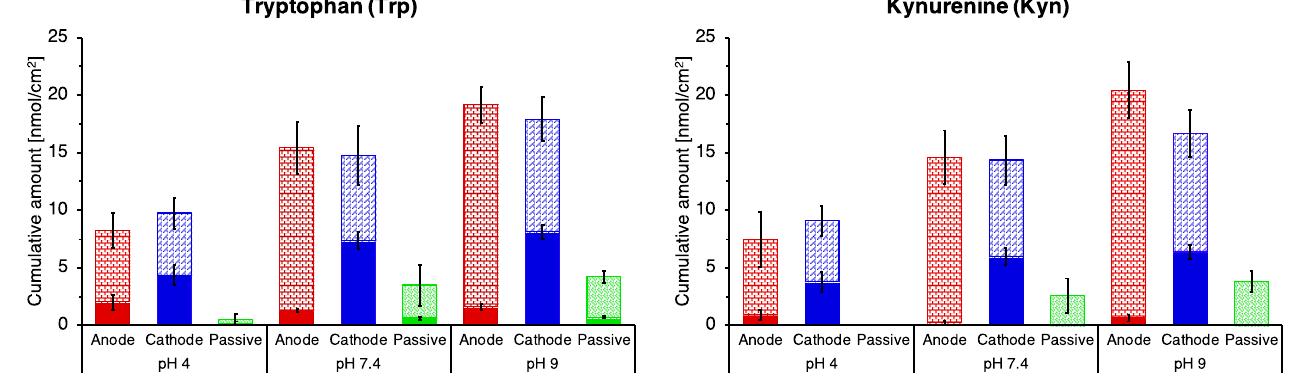
Figure 4. Cumulative anodal, cathodal and passive extraction of Trp and Kyn during 6 h of reverse iontophoresis (filled bars) and during a subsequent (no-current) period of 18 h (stippled bars). Data presented are mean ± SEM; n = 4 – 11, see Table S4 for detail.